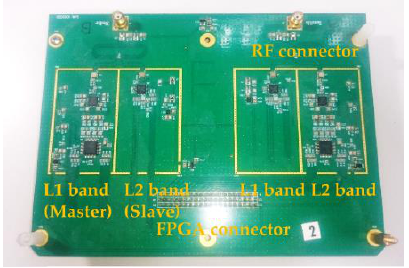
Figure 2. Implemented dual-frequency radio frequency front